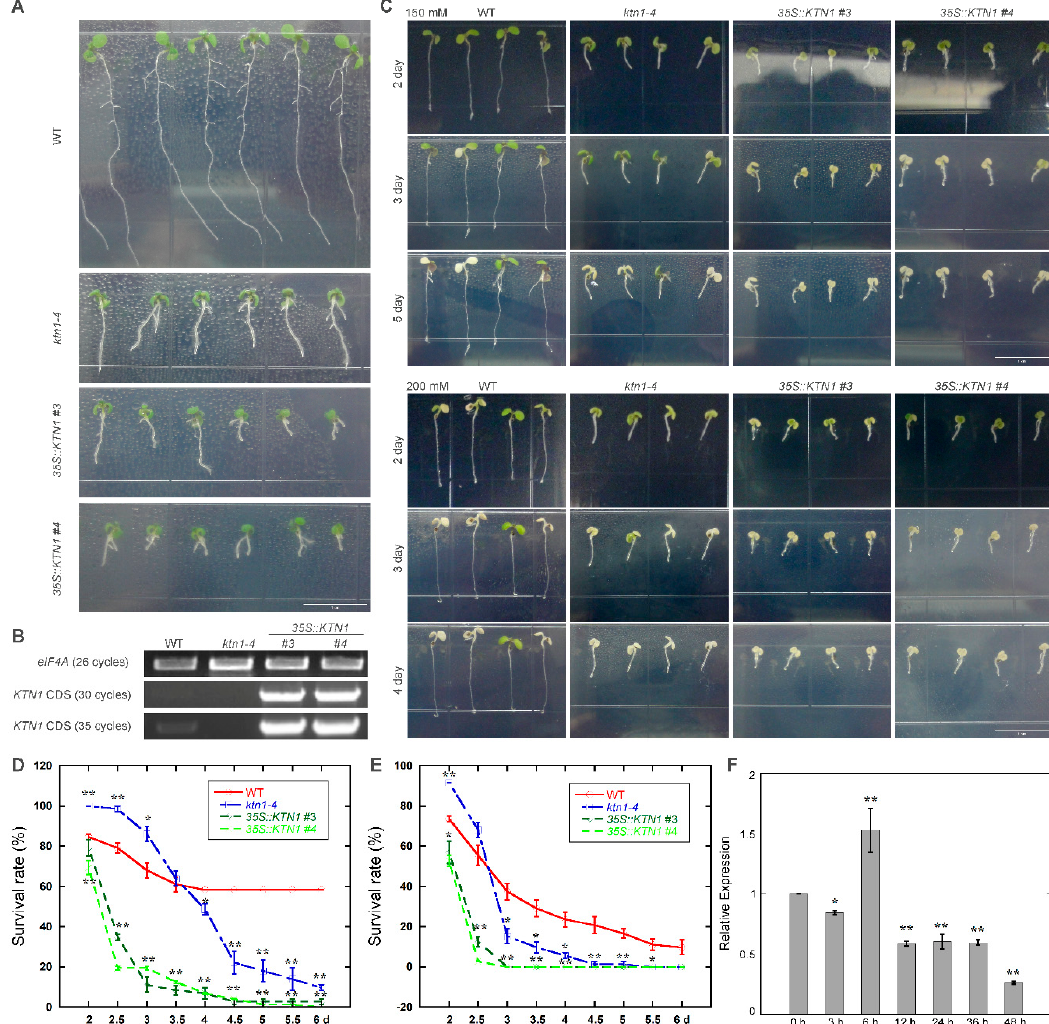
Figure 1. Knock-out of AtKTN1 improves salt tolerance in the early stage of salt treatment but reduces in the later stage. Overexpression of AtKTN1 decreases salt tolerance significantly. ( A ) Seven-day-old Arabidopsis seedlings WT (Col-0), ktn1-4 and 35S::KTN1 (#3, #4) grown under lights. Scale bar = 1 cm. ( B ) RT-PCR analysis of the transcriptional levels of KTN1 in WT (Col-0), ktn1-4 and 35S::KTN1 (#3, #4) seven-day seedlings. eIF4A was used as the control gene. ( C ) Salt sensitivity of WT (Col-0), ktn1-4 and 35S::KTN1 (#3, #4) seedlings under 150 mM and 200 mM NaCl. Seedlings (four-day-old) of wild type and mutants were transferred from 1/2 MS medium to 1/2 MS medium supplemented without or with 150 mM and 200 mM NaCl. Scale bar = 1 cm. ( D ) Survival rates of WT (Col-0), ktn1-4 and 35S::KTN1 (#3, #4) seedlings under 150 mM NaCl. ( E ) Survival rates of WT (Col-0), ktn1-4 and 35S::KTN1 (#3, #4) seedlings under 200 mM NaCl. Surviving seedlings (with green cotyledons) were counted from the second day after transfer. Data shown are mean values SE (error bars) from three independent experiments (n = 48 for each). Asterisks indicate the significance of the mean value differences compared with WT by Student’s t -test, * P < 0.05,** P < 0.01. ( F ) Relative expression levels of AtKTN1 after treatment with 200 mM NaCl for indicated time period in WT seedlings (four-day-old). Error bars indicate SD. * P < 0.05 and ** P < 0.01 by a Student’s t test.